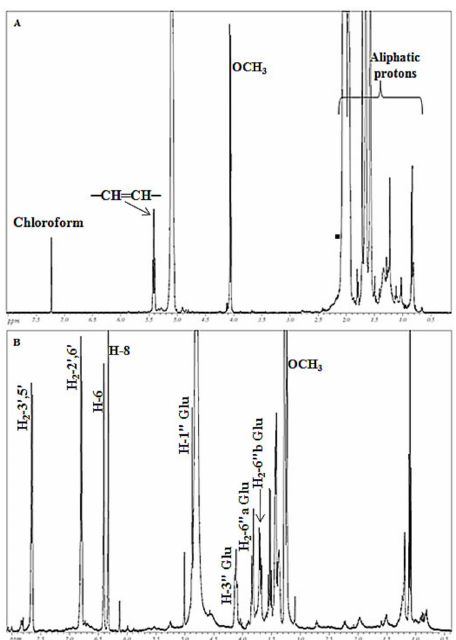
Figure 6. NMR spectra of nonpolar ( A ) and polar ( B ) fractions of J. curcas (genotype B) leaves. Spectrum A shows the main constituent, an unsaturated lipid-alcohol methylester. At higher fields, the signals of the aliphatic protons are present, whereas at 4.08 ppm the signals of methyl groups are visible and at 5.32 ppm those of the double bond proton are visible. In spectrum B, the presence of a glucosyl-3-methylether of kaempherol is indicated. At lower fields the signals of the flavonoid aglycone are present, as AA’BB’ system for protons of ring B and as two doublets for proton H-6 and H-8 of ring A; visible in the middle of the spectrum are the signals of the sugar moiety with, in particular, the H-3” of the glucose with an ethoxy group.